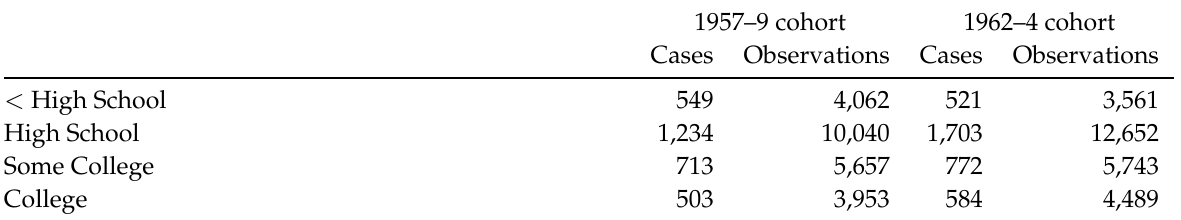
Table 3: Numbers of Cases and Income Observations by Educational